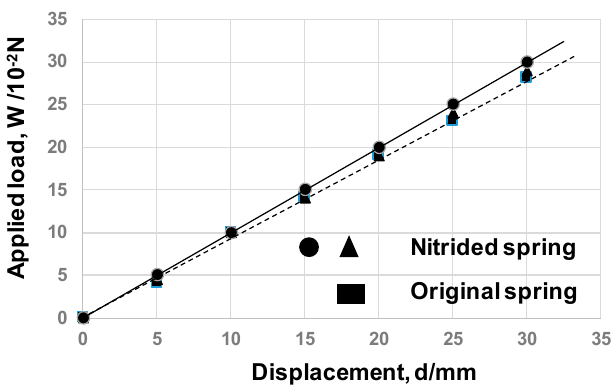
Figure 8. The load–displacement relationship for the original spring and two nitrided springs.